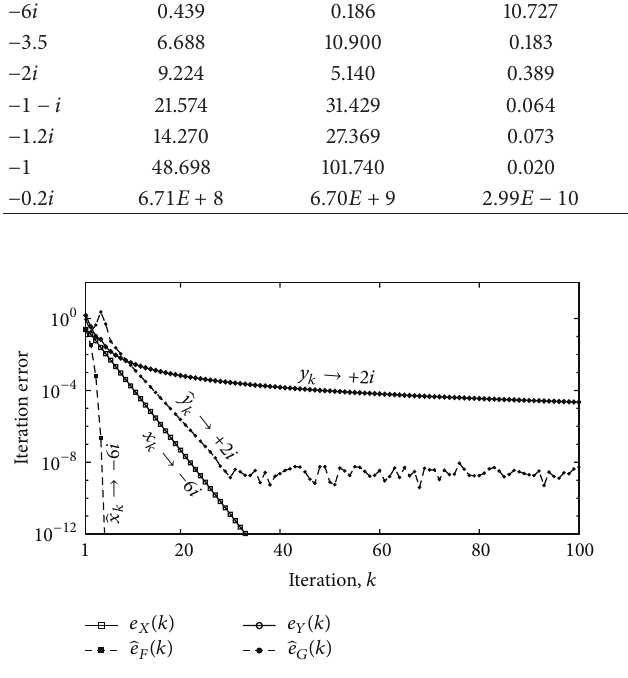
Figure 3: Example 2. Iteration errors. Pivots are 𝑢 = −1.22 − 5.50𝑖 and V = −1.48 + 2.50𝑖